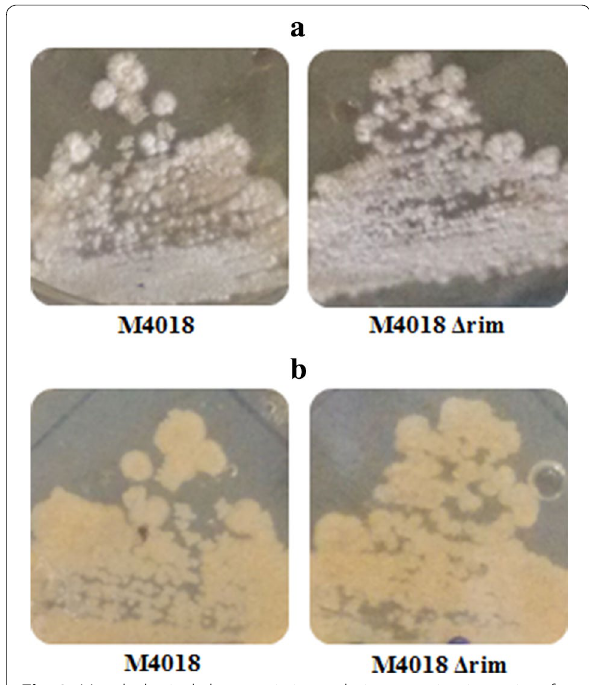
Fig. 3 Morphological characteristics and pigmentation intensity of the parental strain M4018 and M4018 Δrim on TSB agar medium. a Morphological characteristics of M4018 and M4018 Δrim on TSB after 4 days of cultivation. Pictures were taken from the upper side of the plates. b Culture pigmentation associated with OTC production by M4018 and M4018 Δrim culture on TSB after 4 days of cultivation. Pictures were taken from the bottom side of the